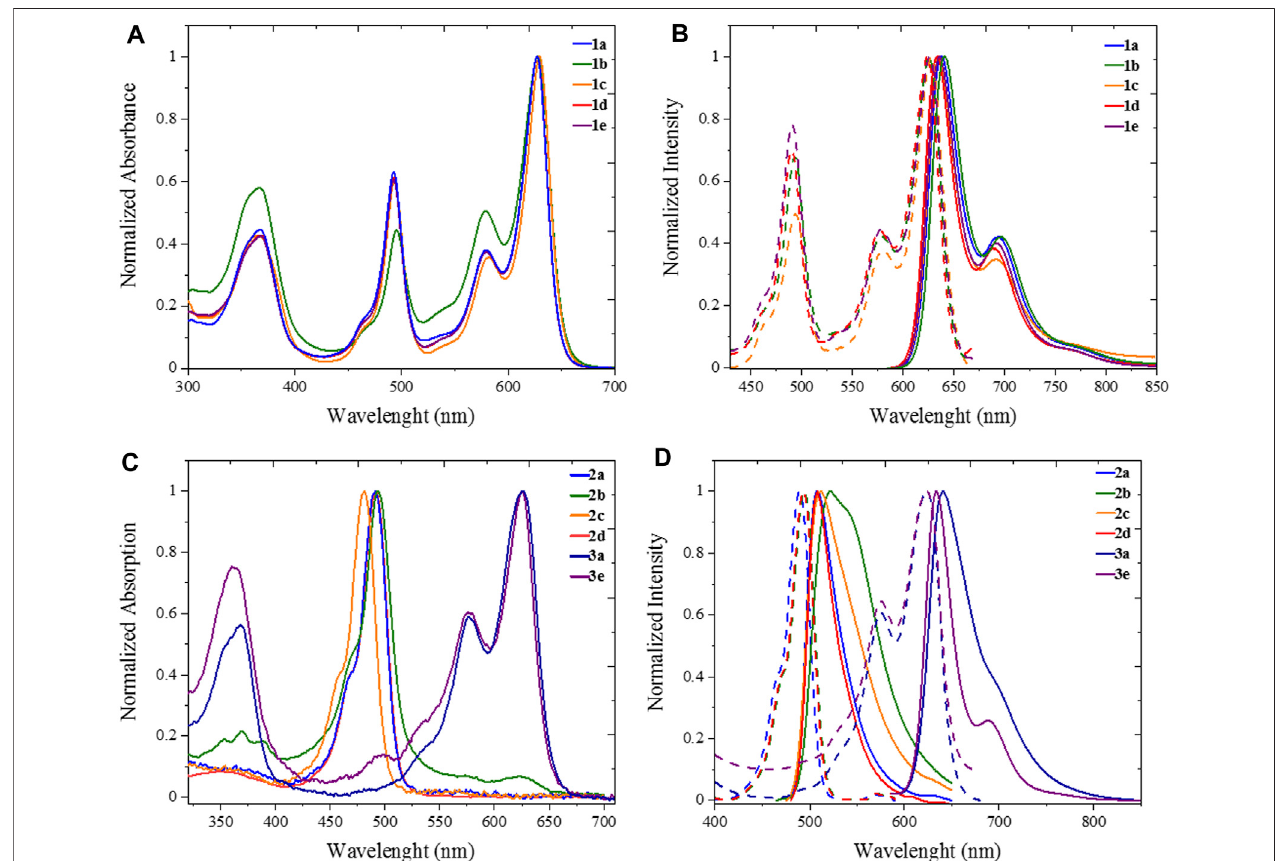
FIGURE 3 | UV Photophysics in spectroscopic toluene for heteroleptic complexes 1a-e (top) and homoleptic complexes 2a-d , 3a and 3e (bottom). (A) Uv/Vis absorption and (B) excitation (dashed plot, λ em (cid:1) 710 nm) emission (solid plot, λ exc (cid:1) 570) spectra of 1a-e . (C) Uv/Vis absorption and (D) excitation (dashed plot, λ em (cid:1)